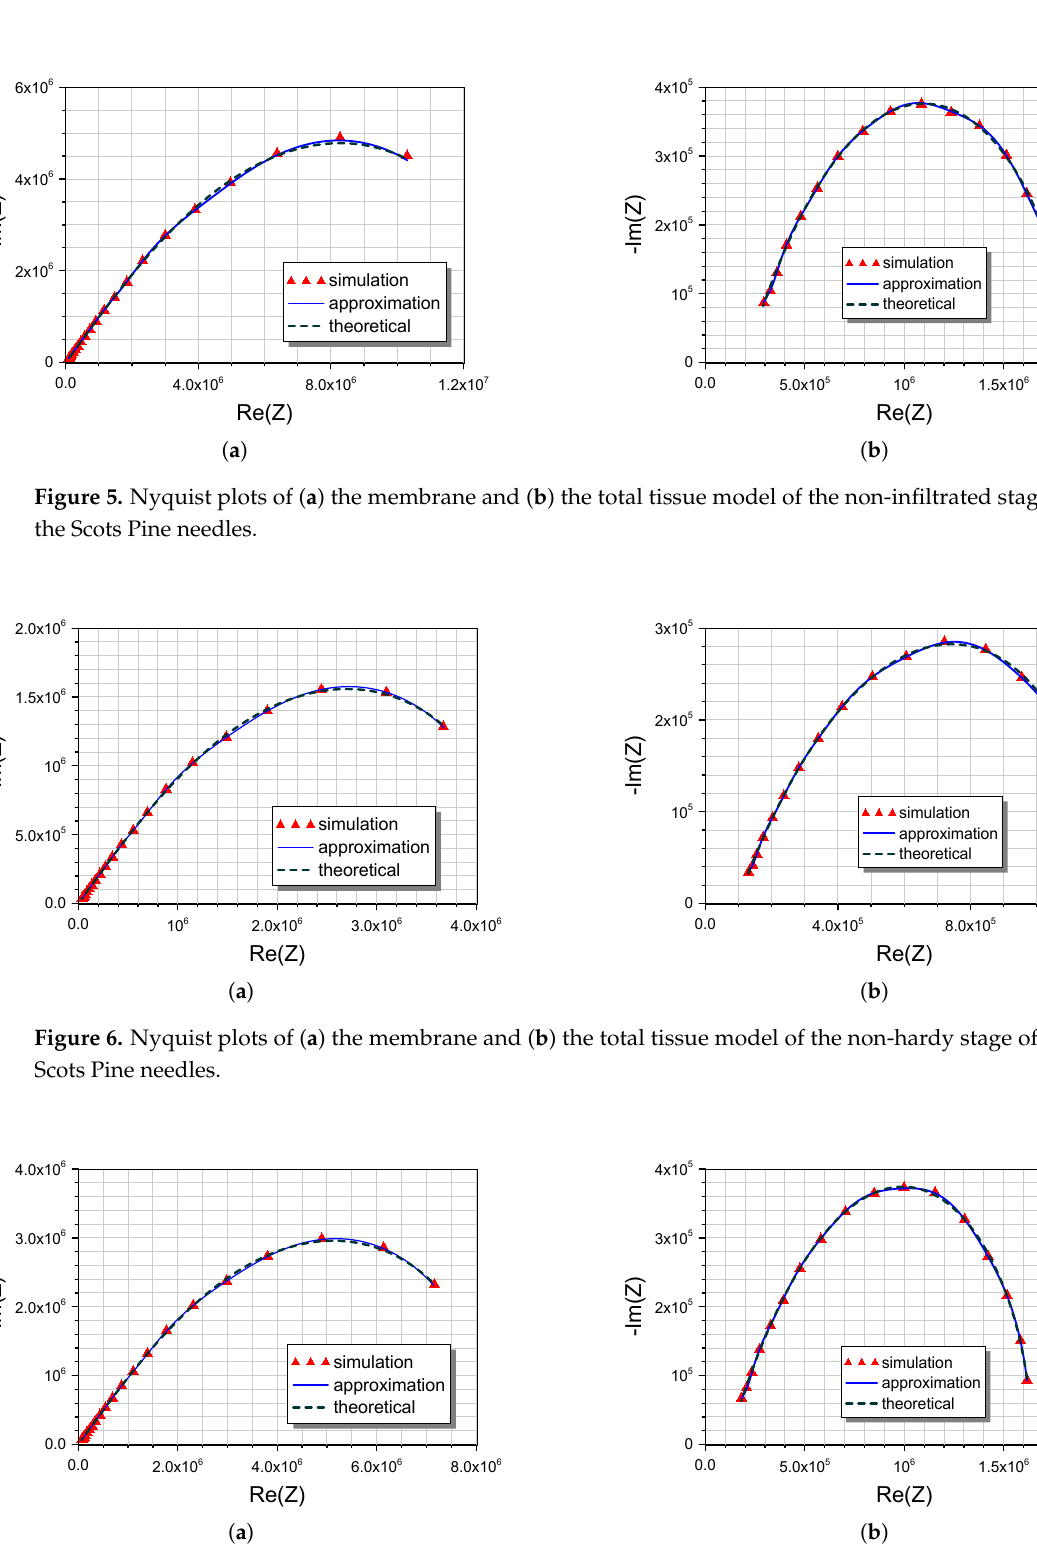
Figure 7. Nyquist plots of ( a ) the membrane and ( b ) the total tissue model of the hardy stage of the Scots Pine